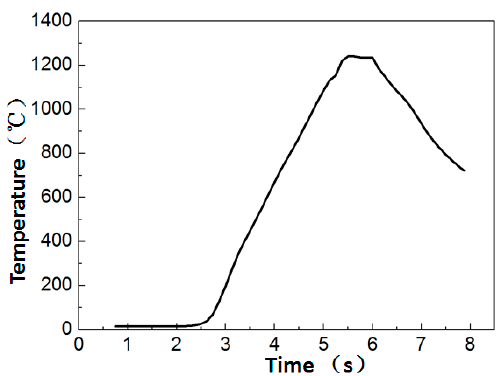
Figure 5. Temperature curve measured during Ti 3 Al LFW.